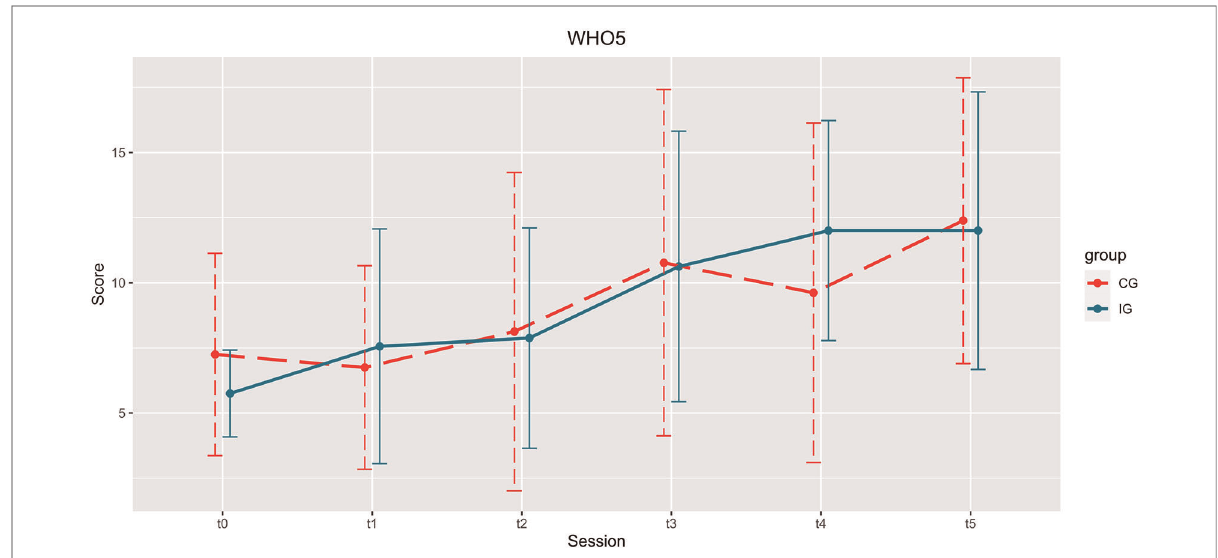
FIGURE 6 Development of the WHO5 scores over the course of the study. Depicted are means and standard deviations